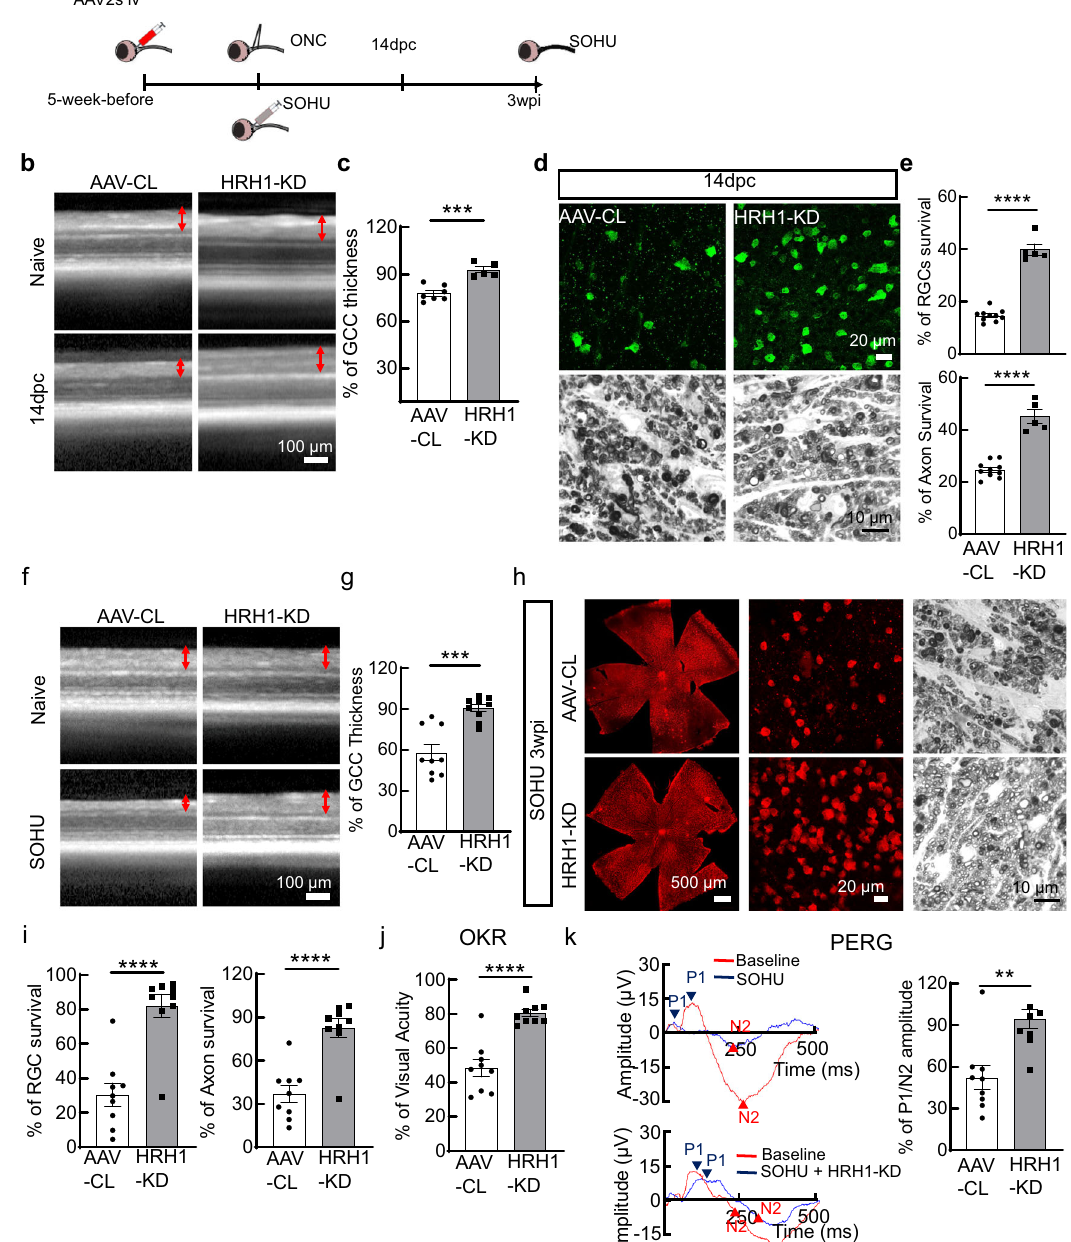
Fig.7|AAV-mediatedinvivoCRISPRKDofHRH1inRGCssigni fi cantlyprotects RGCs and ONs and preserves visual function in two optic neuropathy models. a Schematic illustration of the timelines of AAV injection and evaluation of neu- roprotection in two optic neuropathy models. b Representative OCT images of mouse retina in at 14dpc. GCC is indicated as double end red arrows. c Quanti fi cation of GCC thickness measured by OCT at 14dpc. AAV-CL, n =7 mice; HRH1-KD, n=5 mice. d Upper panel: representative confocal images of the wholemountretinas;Lowerpanel:representativelightmicroscopeimagesofsemi- thin transverse sections of ON with PPD staining at 14dpc. e Quanti fi cation of surviving RGC somata in wholemount retinas and axons in ON sections at 14dpc. n =10miceforAAV-CL,Amo; n =5miceforHRH1-KD. f RepresentativeOCTimages of mouse retina in living mice with SOHU glaucoma at 3wpi. GCC is indicated as